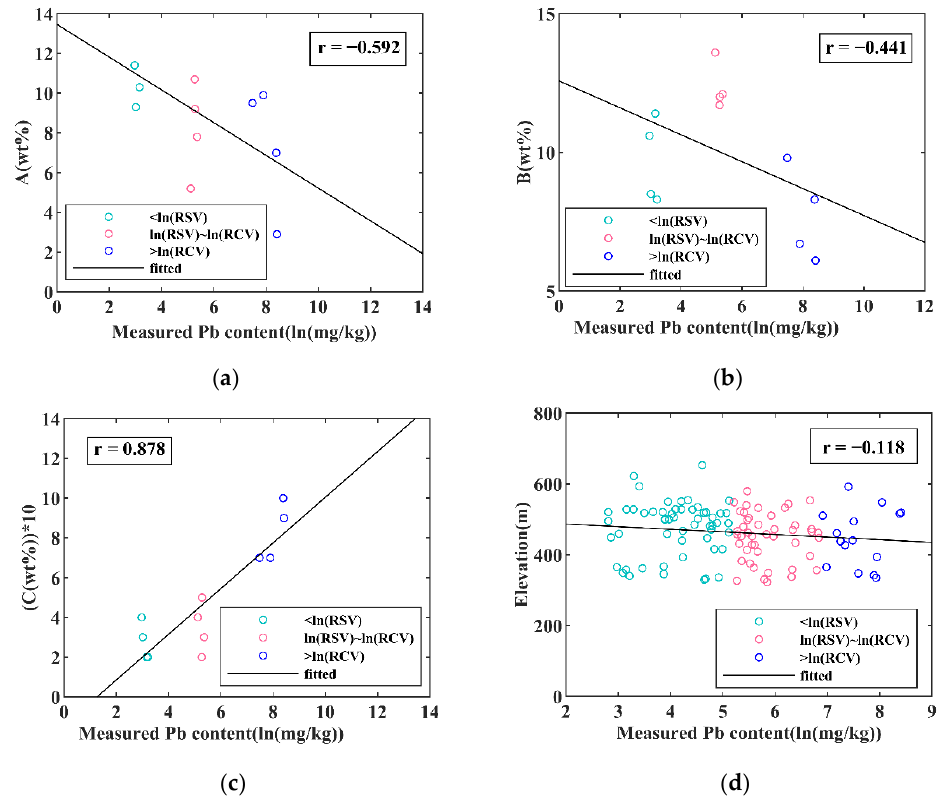
Figure 10. Relationship between measured Pb content and some factors, ( a ) the total amount of calcite, chlorite, and clinochlore represented by A (wt%); ( b ) the total amount of kaolinite, illite, and muscovite represented by B (wt%); ( c ) the total amount of Pb bearing minerals represented by C (wt%); ( d ) sample elevation. wt% represents the weight percentage of minerals. The green dots represent the Pb value lower than ln(RSV) (5.14 ln(mg/kg)), the red dots represent the Pb value between ln(RSV) and ln(RCV) (5.14–6.91 ln(mg/kg)), and the blue dots indicate the Pb value higher than ln(RCV) (6.91 ln(mg/kg)).